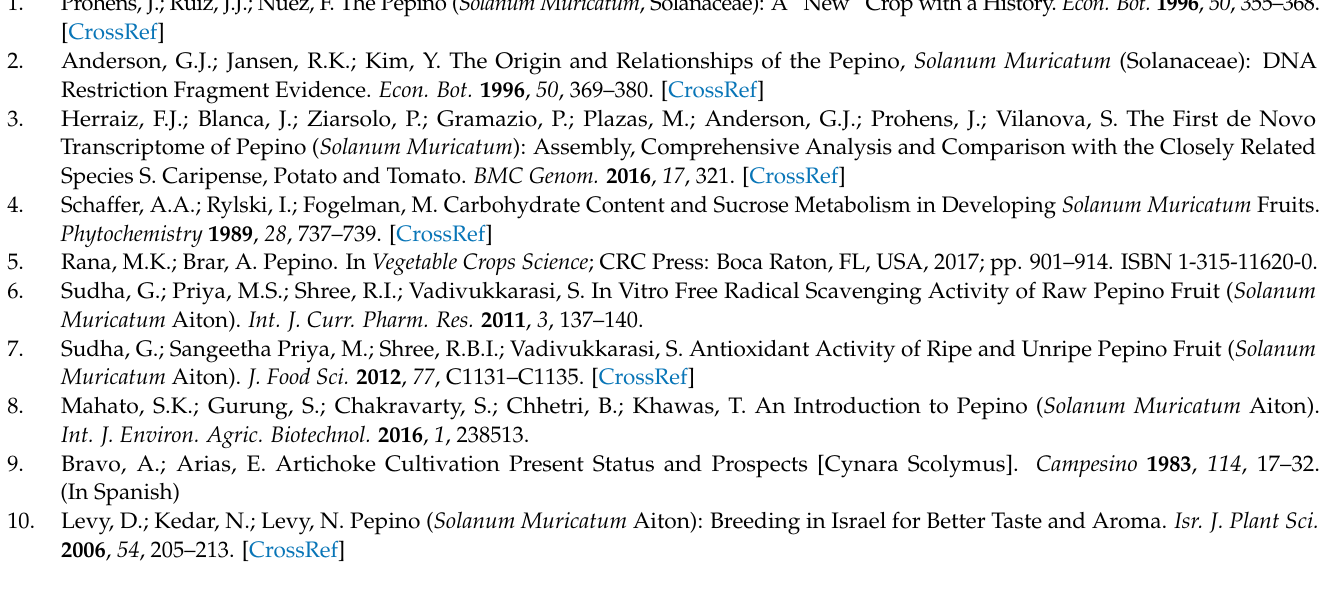
regional pepino samples; Figure S2: Total insolation in the three areas; Figure S3: Net insolation in the three areas; Figure S4: Temperature in the three regions; Table S1: 269 identified metabolites; Table S2: 99 different metabolites; Table S3: The relative content of the nine specific metabolites groups. Documents S1: Raw data; Documents S2: Annotation